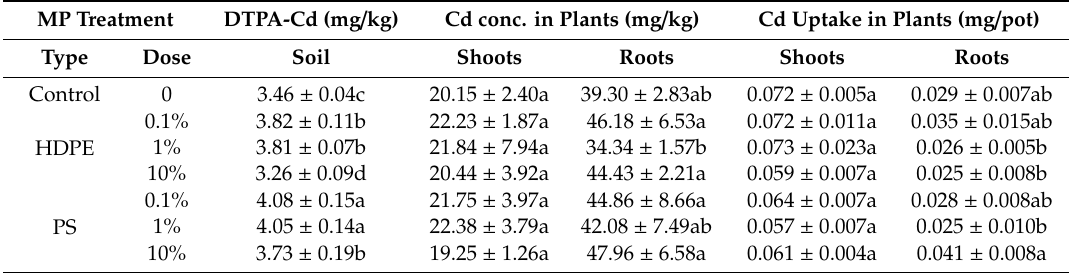
Table 4. Diethylenetriaminepentaacetic acid (DTPA)-extractable Cd concentrations in soil, and Cd concentrations and uptake in maize plants exposed to MPs with Cd. Di ff erent letters following the mean values ± SD ( n = 4) in the same column indicate significant di ff erences using a one-way ANOVA followed by Duncan’s multiple range test ( p < 0.05). Two-way and three-way ANOVA results are shown in Tables 2 and 3,